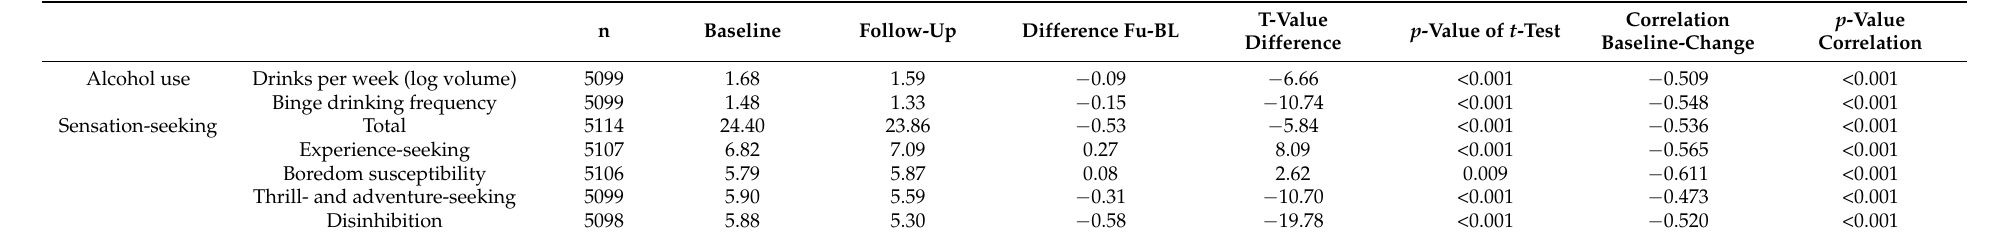
Table 2. Descriptive characteristics of changes in alcohol use and sensation seeking from baseline to